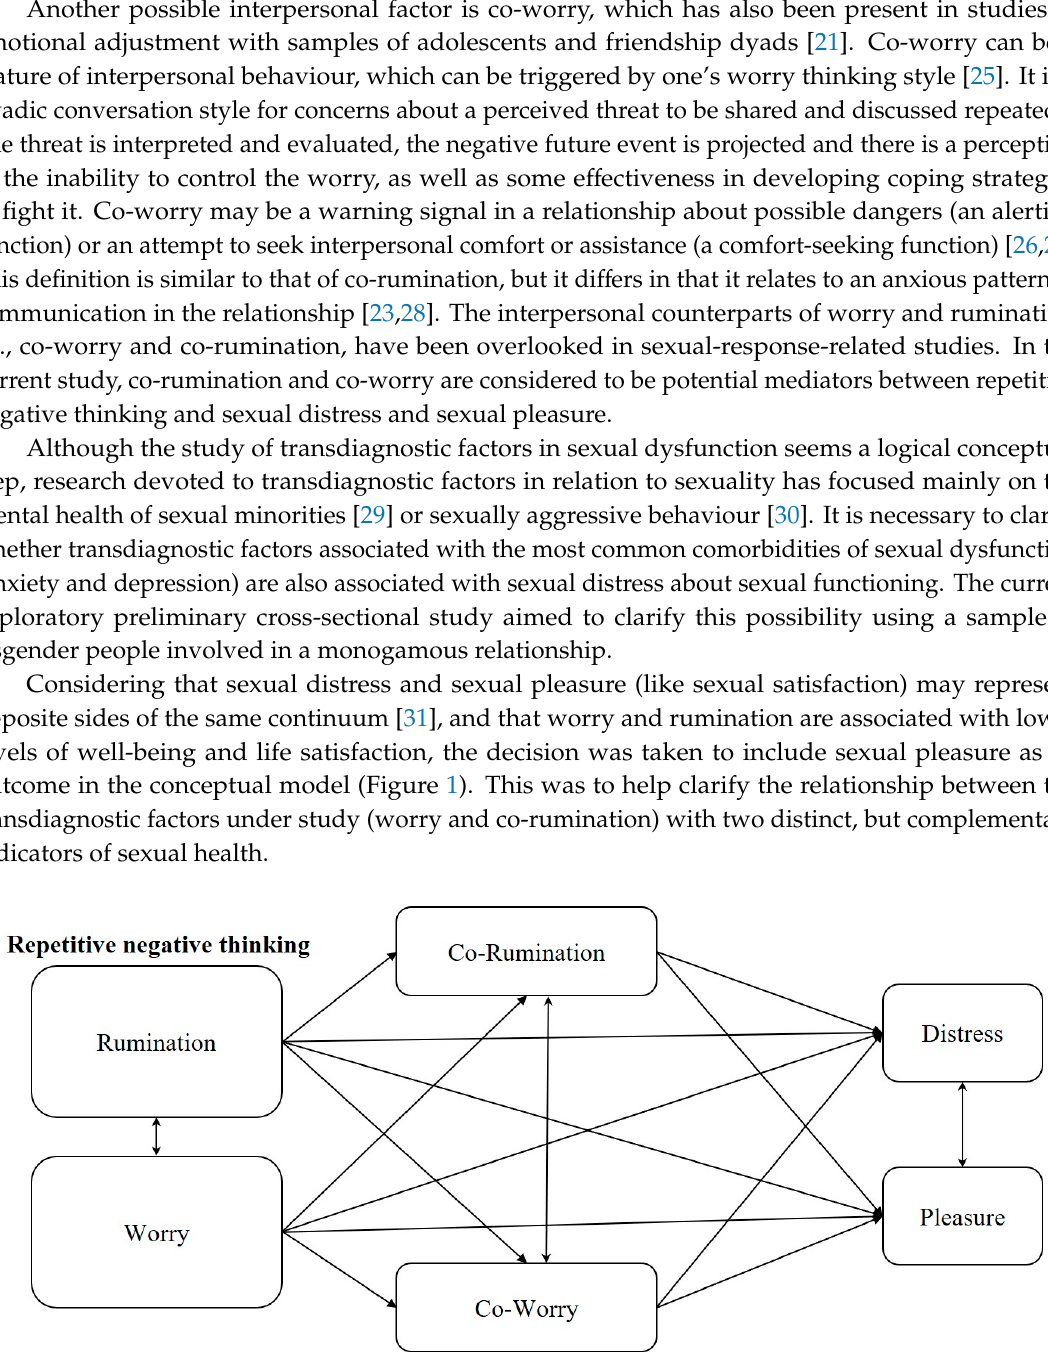
Figure 1. Conceptual mediation model of the relationships between repetitive negative thinking and sexual distress and sexual pleasure.